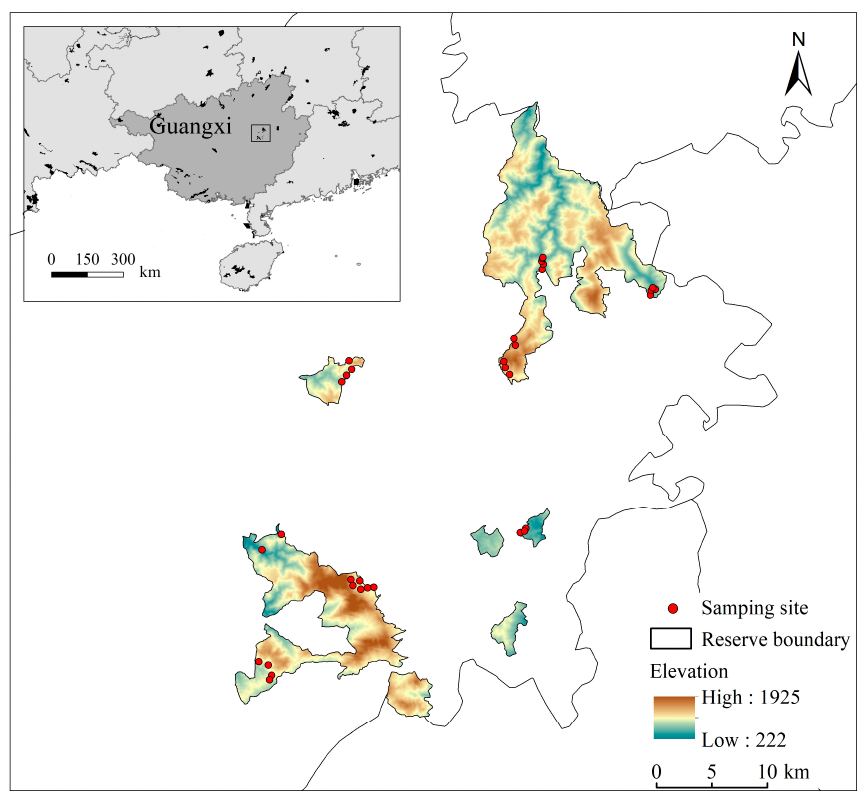
Figure 1. Location of the Dayao Mountain National Nature Reserve and plant survey sample